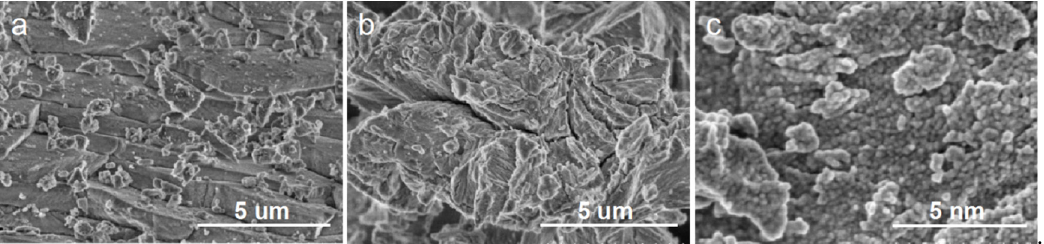
Figure 2. Scanning electron micrographs before and after shell modification and modified loading: font ( a ) SP (5 um), ( b ) MSP (5 um) and ( c ) La-Fe-TiO 2 @ MSP (5 nm).